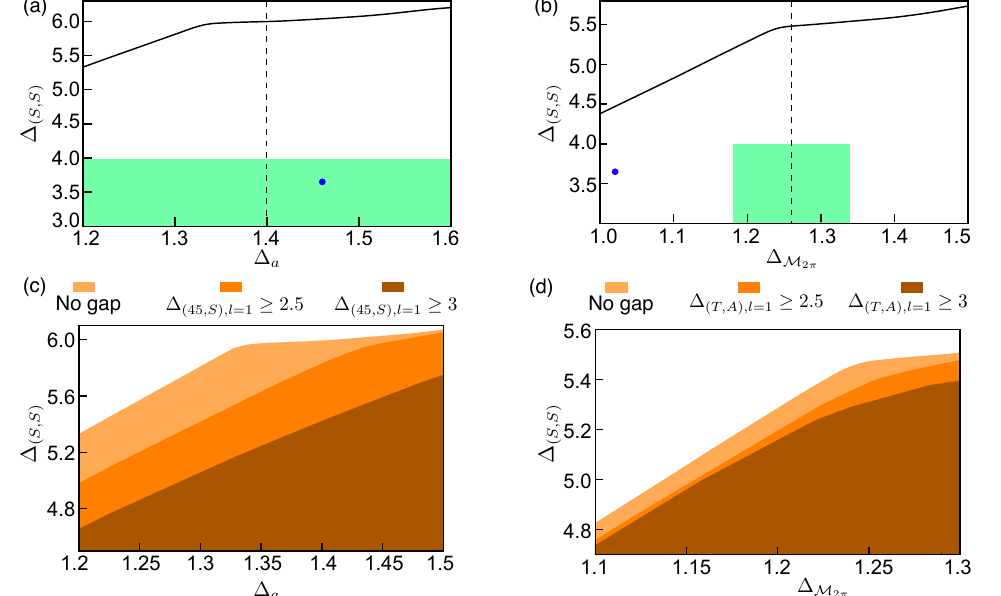
Figure 1: (a-b) Numerical bounds (black curve) of the lowest scalar in the singlet channel ∆ ( (a) from the single correlator of the SO ( 6 ) adjoint (i.e. fermion bilin- S , S ) ear operator denoted by a ) and (b) from the single correlator of the SO ( 6 ) × SO ( 2 ) bi-vector (i.e. monopole operator denoted by π ). The blue circles correspond M 2 = 4 QED to the large- N results of the N . The dashed lines are the Monte Carlo f f 3 = 4 QED = 1.4 ( 2 ) and ∆ = 1.26 ( 8 ) [ 29–31 ] . estimates for the N , namely ∆ M 2 π f a 3 = 4 QED The region in green is where the N likely lives in. (c-d): The zoomed f 3 in numerical bounds ∆ ( with various gap assumptions imposed. The kinks dis- S , S ) = 4 appearing under a mild gap shows that they should not be identified as the N f QED . Here we take Λ = 3